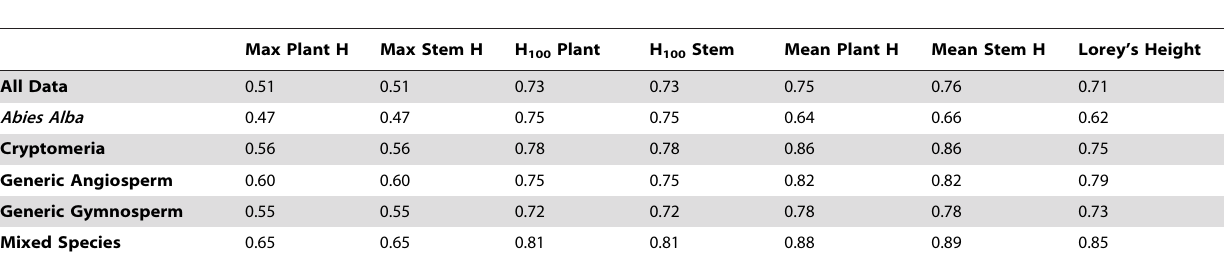
Table 2. r 2 values comparing best fitting curve of height classes to forest volume generated from the combination of all forest datasets of default resources with individual forest composition examples.